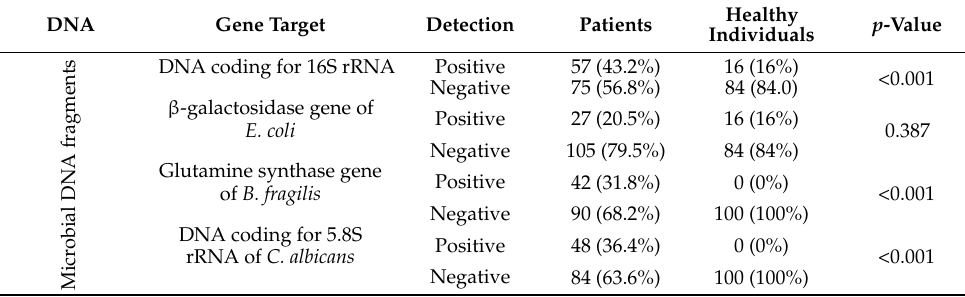
Table 2. Association of microbial DNA fragments between CRC patients and healthy subjects.